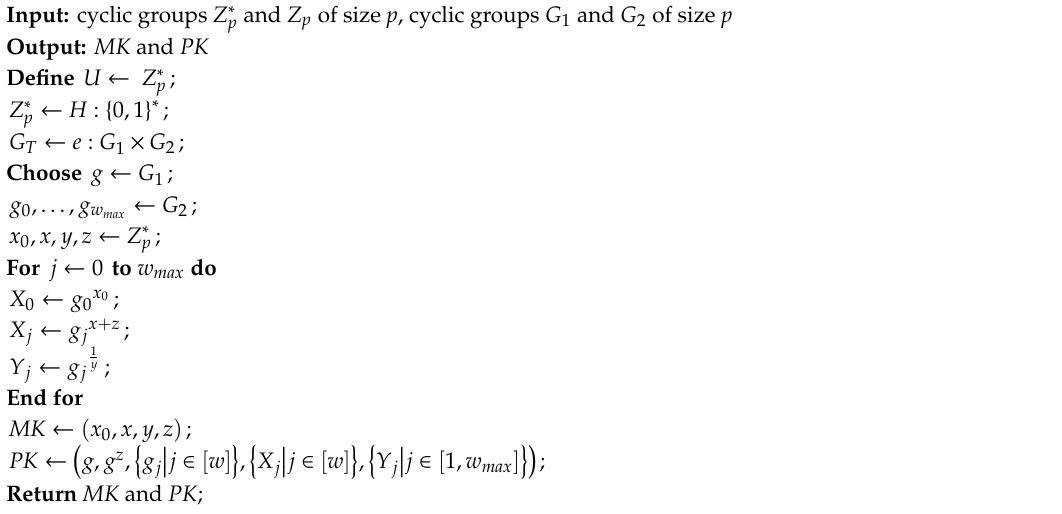
Algorithm 2 Master Key and Public Key